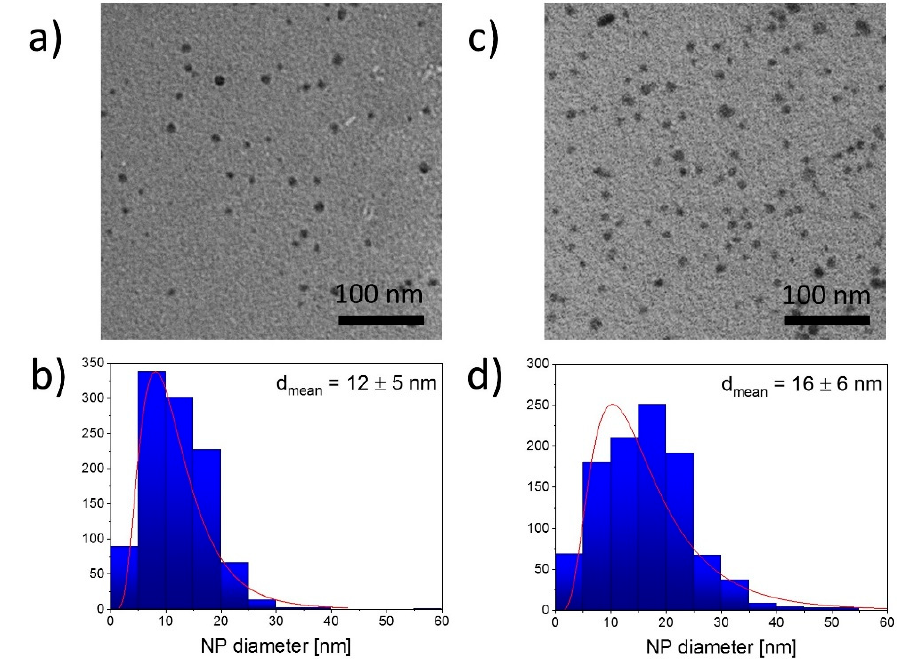
Figure 4. ( a , c ) TEM images and ( b , d ) size distributions of silver nanoparticles (Ag NPs) prepared using the plasma-solution processes with the liquid cathode (left) and liquid anode (right). Treatment time, 30 min.